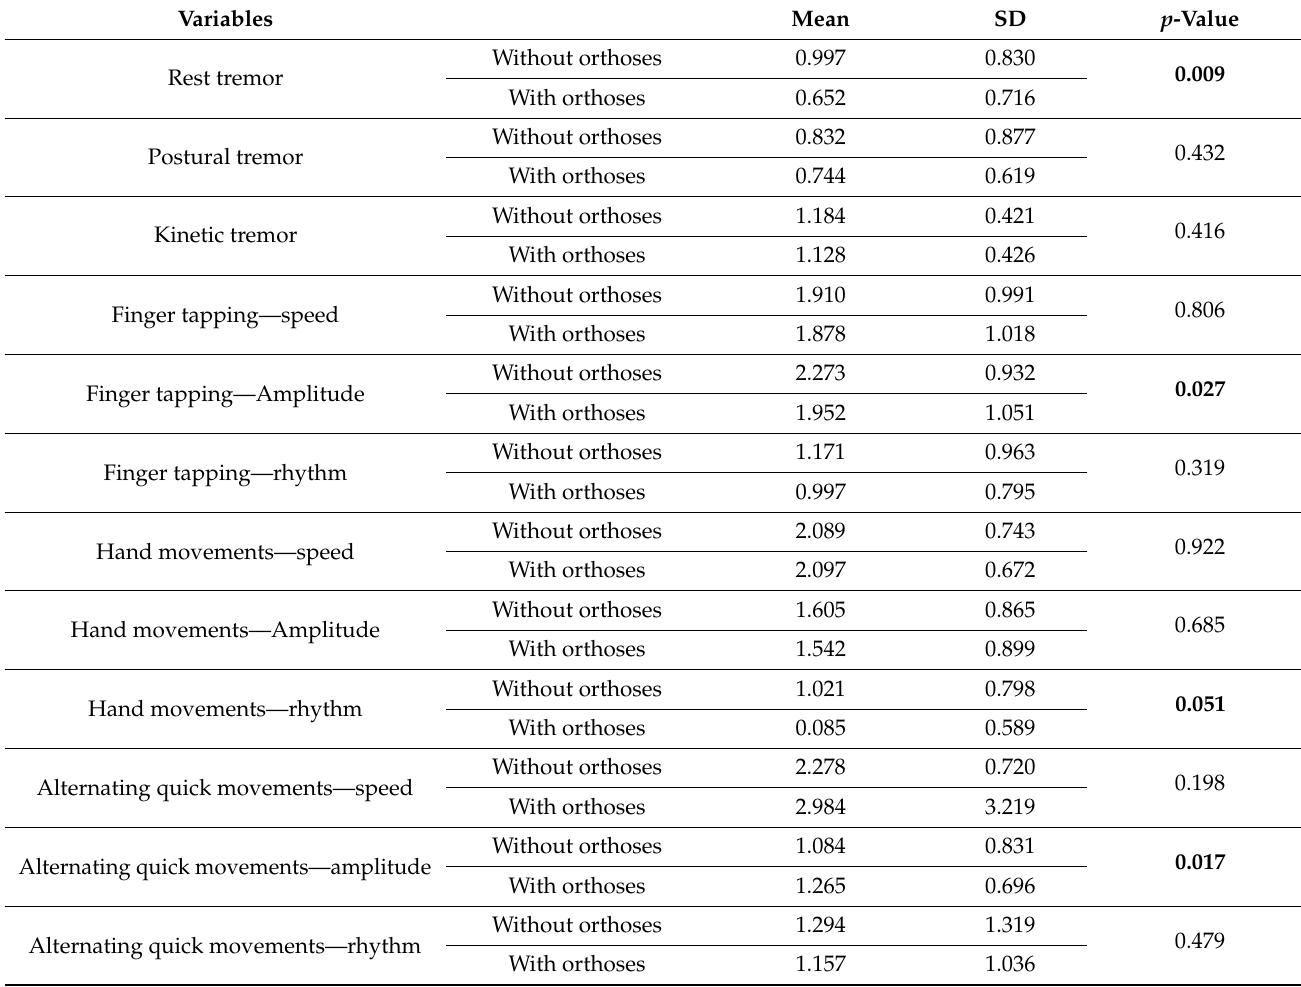
Table 4. Kinessia ON state, with and without orthoses—baseline assessment ( n = 40). Variables